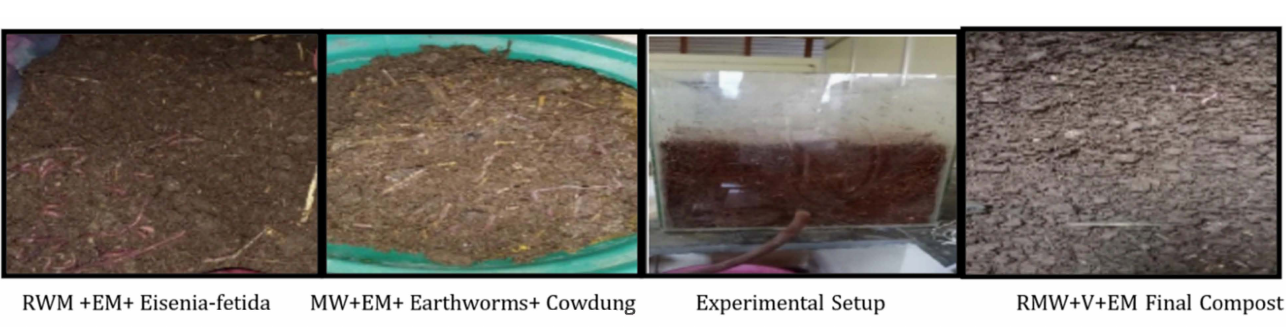
Figure 4. Set up 3 shows the images of mushroom waste with vermicomposting and EM [MW+V+EM].